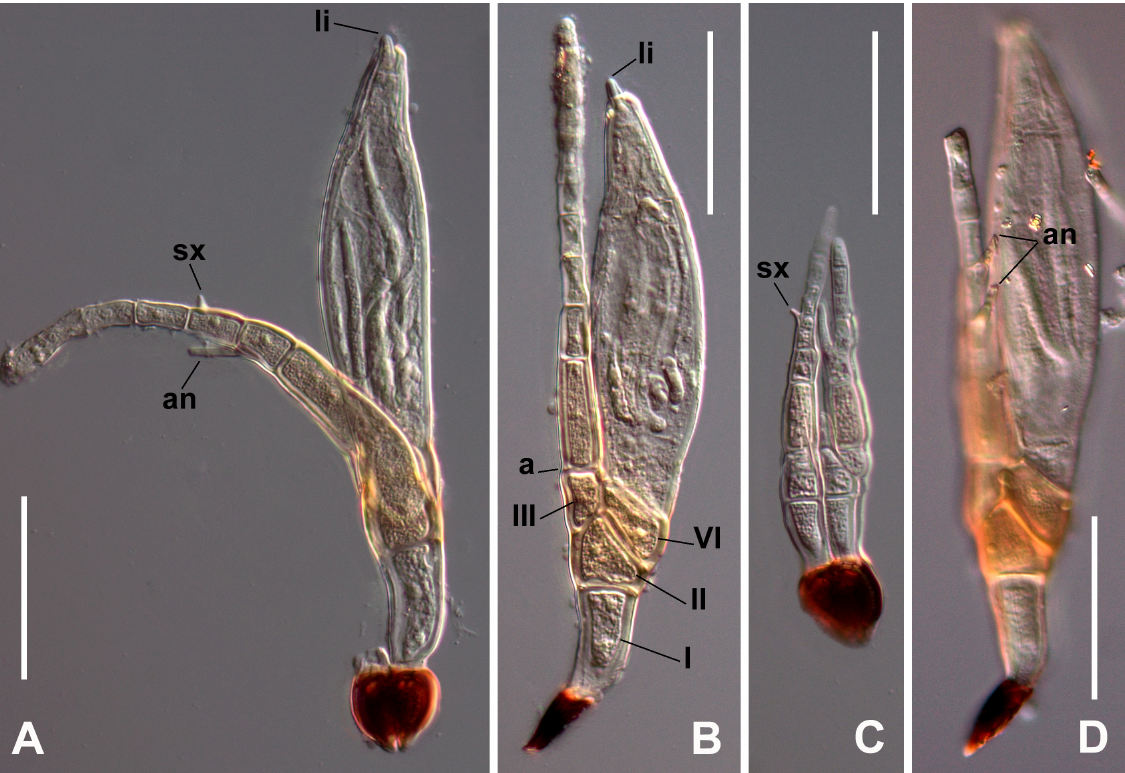
Fig. 2. Diplopodomyces liguliphorus Santam., Enghoff & Reboleira sp. nov. A – B . Mature thalli with labelling of cells and other elements. C . Pair of young thalli focused to show the original spinous spore apex (sx). D . Mature thallus focused to show the antheridium (an). Scale bars: 50 µm. Photographs from: slides C-F-92267 (A–B), SS E575c (C) and SS E575a